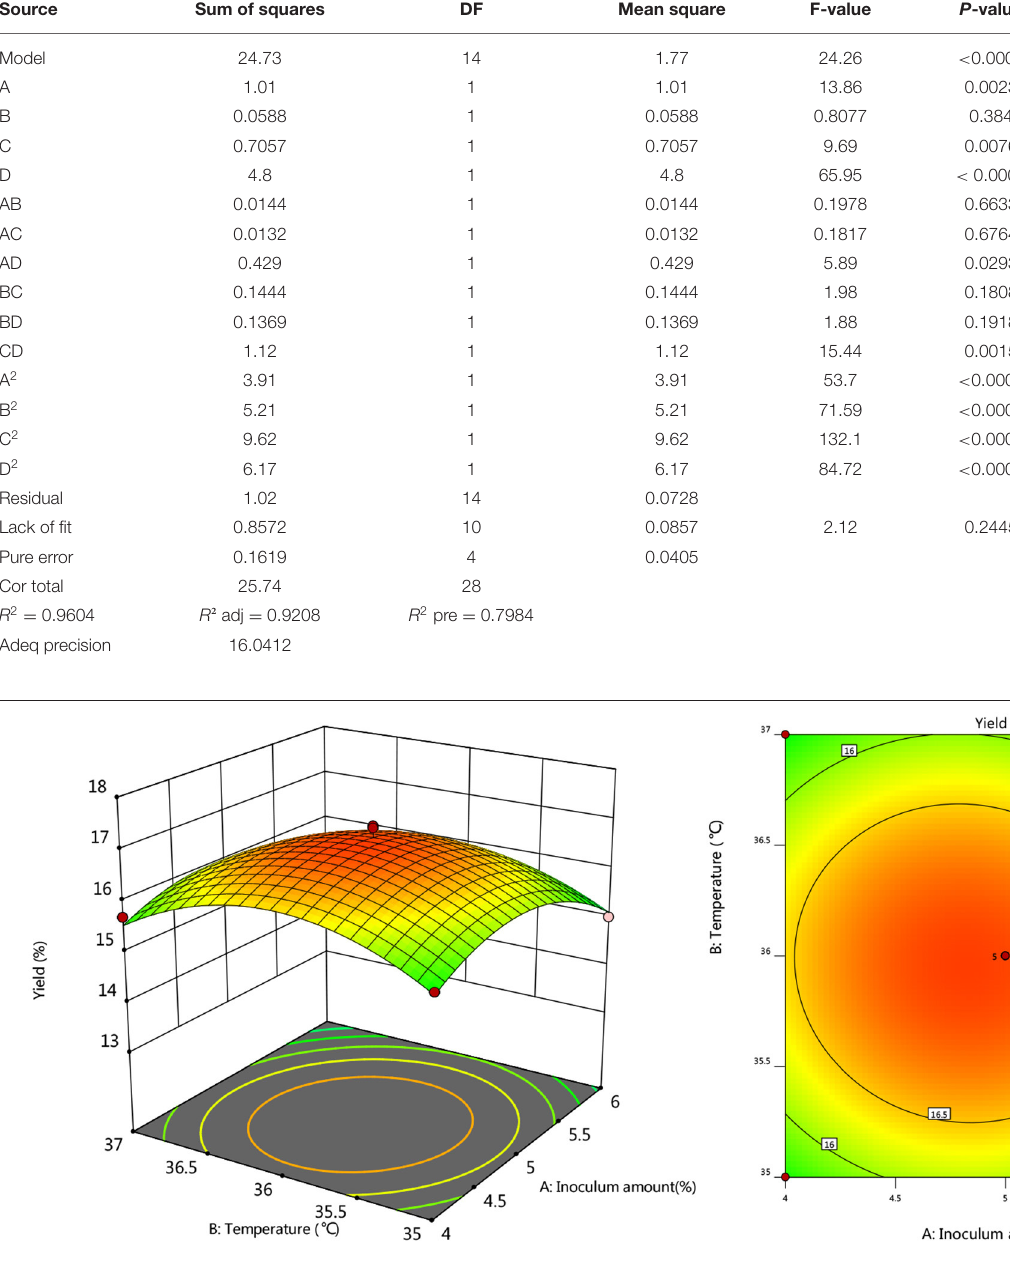
The test was carried out to examine the antioxidant of Artemisia polysaccharides using ascorbic acid as a positive control, as shown in Figure 12 . Artemisia polysaccharides and ascorbic acid showed a scavenging effect on DPPH, ABTS + , and OH radicals and there was a dose-dependent relationship. The